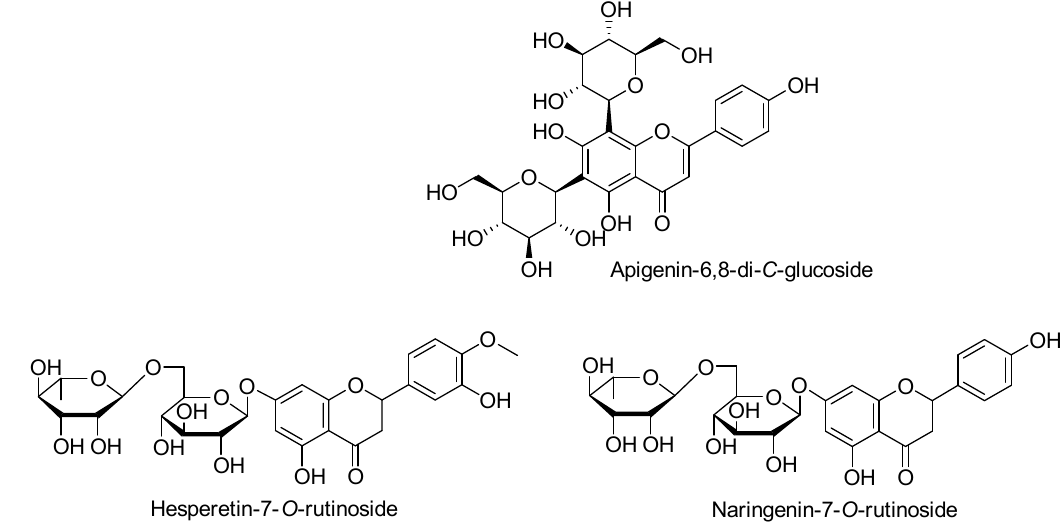
Figure 5. Structures of the major phenolic compounds identified in fresh, thermal pasteurized (TP), and high-pressure processed (HPP) orange juices. Table 2. Degradation kinetic parameters of TPC, total anthocyanin content, total flavonoid content, total carotenoid content, and ARP for thermal pasteurized (TP) and high-pressure processed (HPP) orange juices stored for 36